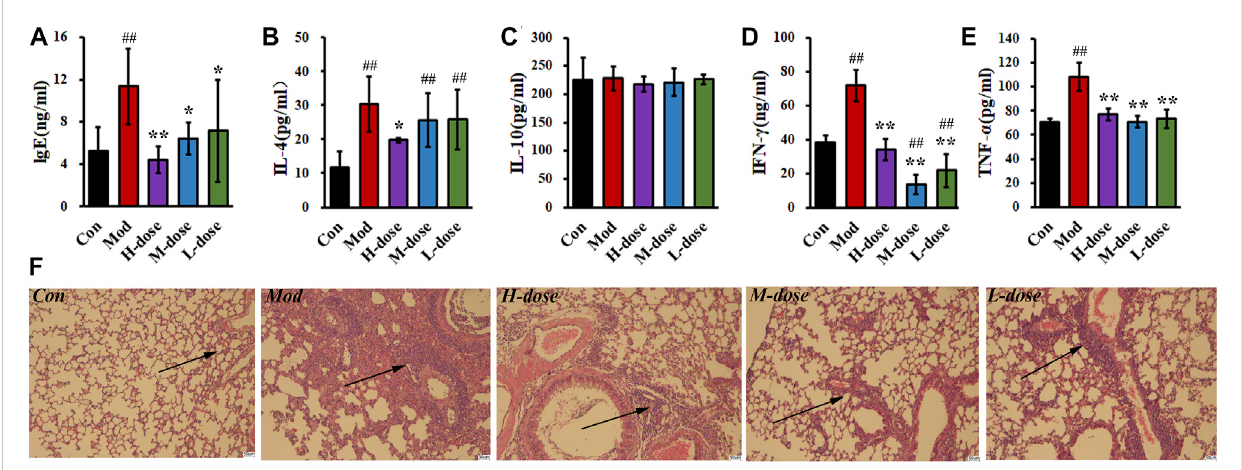
SXCFreducestheexpressionofrelevantcytokinesinserumandBALFanddecreasesthein fi ltrationofin fl ammatorycells. (A) IgEinserum, (B) IL-4in BALF, (C) IL-10 in BALF, (D) IFN- γ in BALF, (E) . TNF- α in BALF. (F) . Lung histology analysis of different groups. n = 6, ## vs . Con, p ≤ 0.01, ** vs . Mod, p ≤